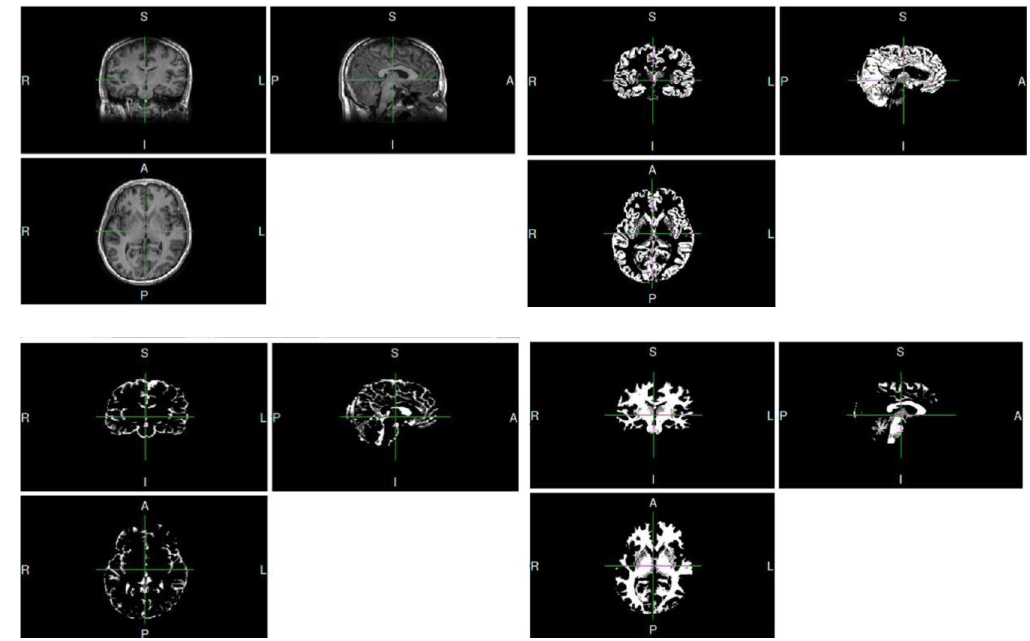
Fig 2. The T1 data (upper left) were segmented into gray matter (upper right), cerebrospinal fluid (lower left), and white matter (lower